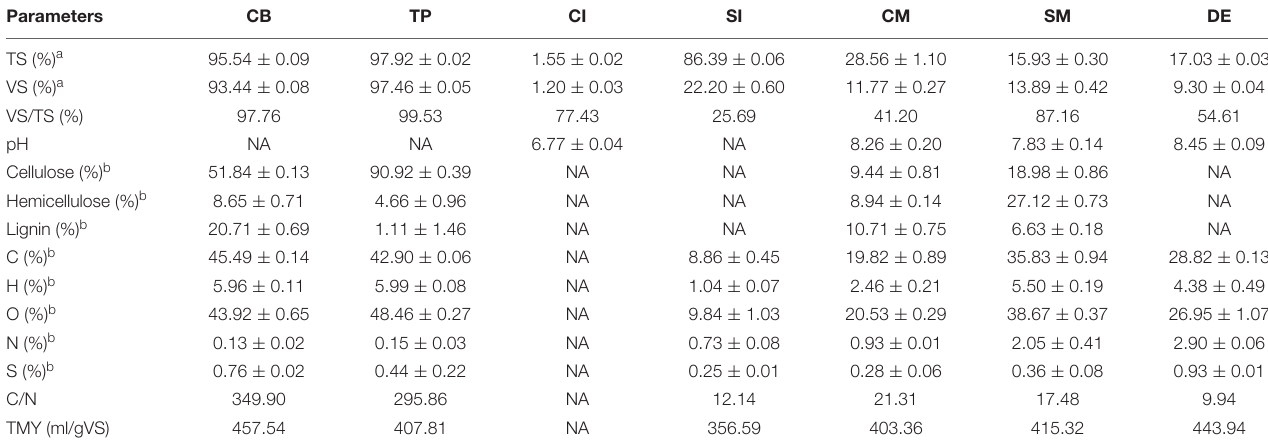
TABLE 1 | Characteristics of substrates and microbial agents.